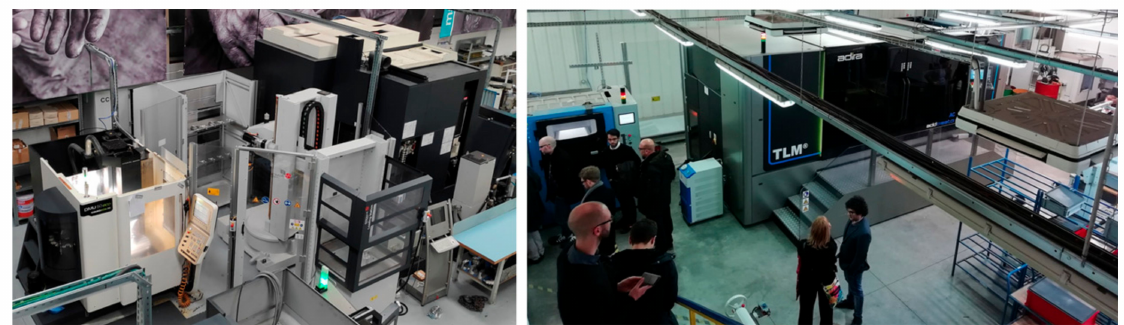
Figure 13. Final demonstrations of the Hybrid SLM production cell at POLY-SHAPE ( right ) and post-processing cell for machining SLM parts in RAMEM ( left